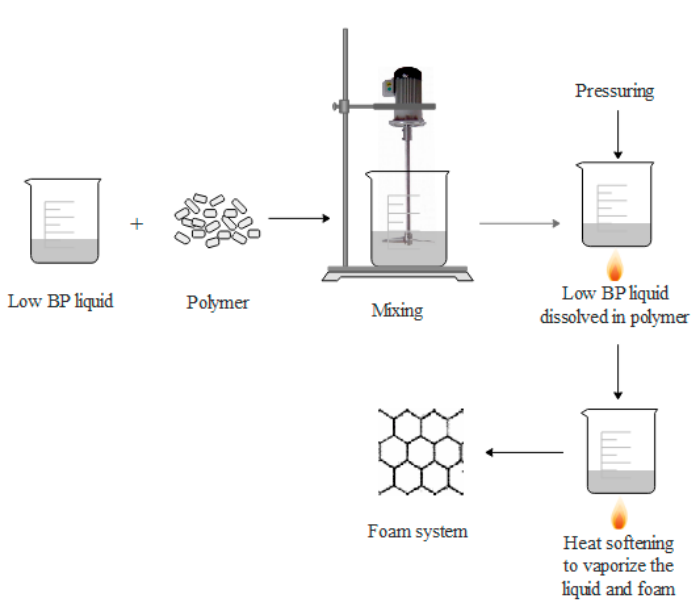
Figure 3. Schematic diagram of physical foaming, reproduced from [66] under open access license.